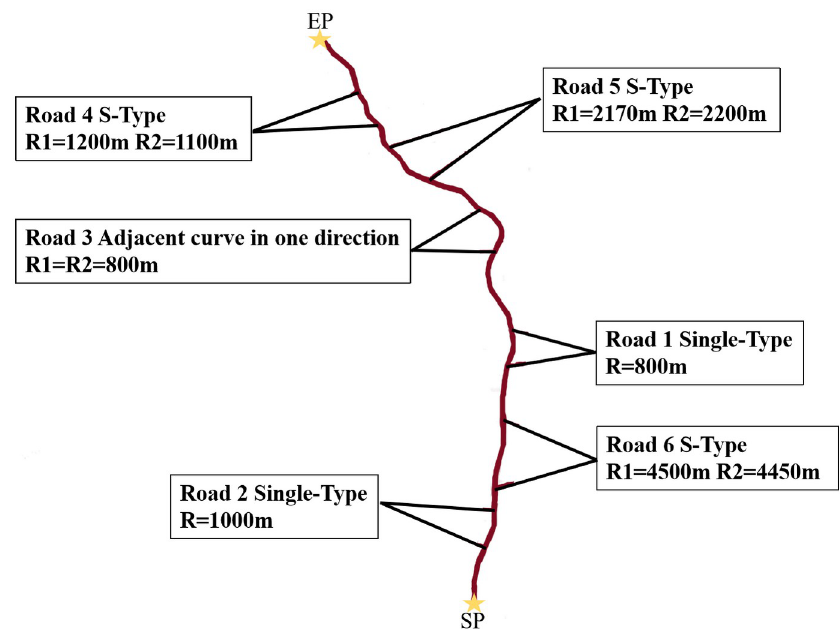
Fig 3. The 6 curves’ actual positions (SP means start point, was Xianyang North toll station, EP means end point, was Chunhua North toll